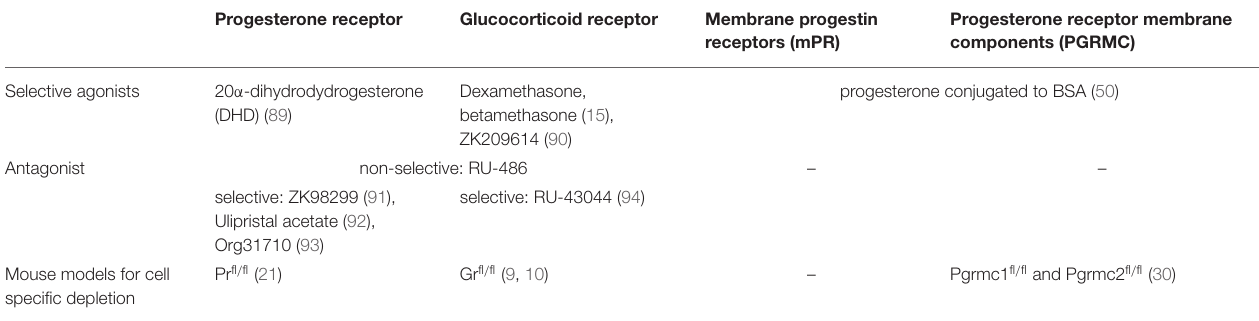
TABLE 2 | Salient technical tools available to discriminate steroid receptor-specific